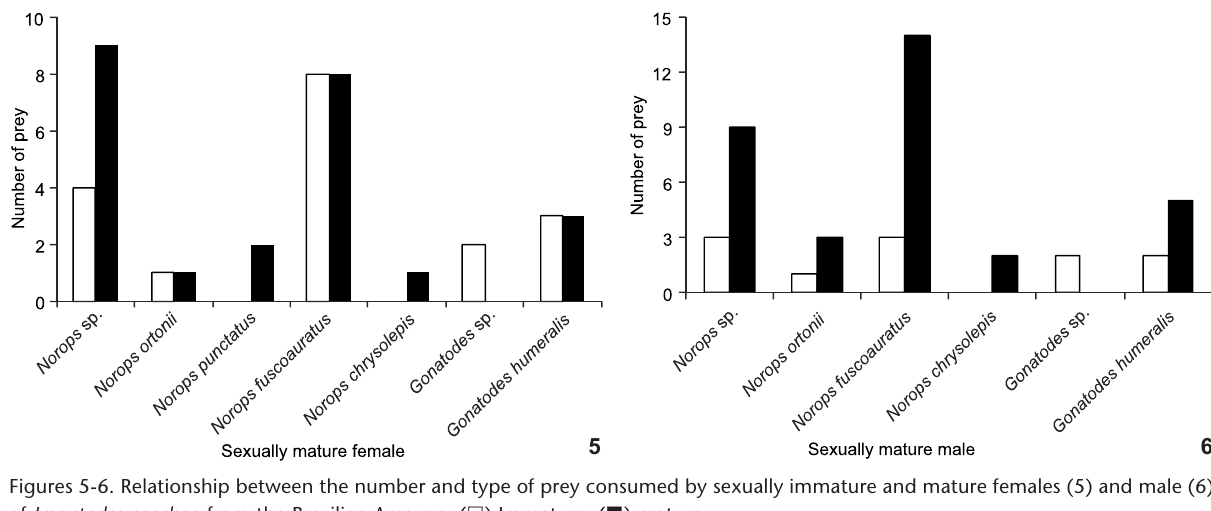
Figures 5-6. Relationship between the number and type of prey consumed by sexually immature and mature females (5) and male (6) of Imantodes cenchoa from the Brazilian Amazon. ( (cid:133) ) Immature, ( (cid:132) ) mature.